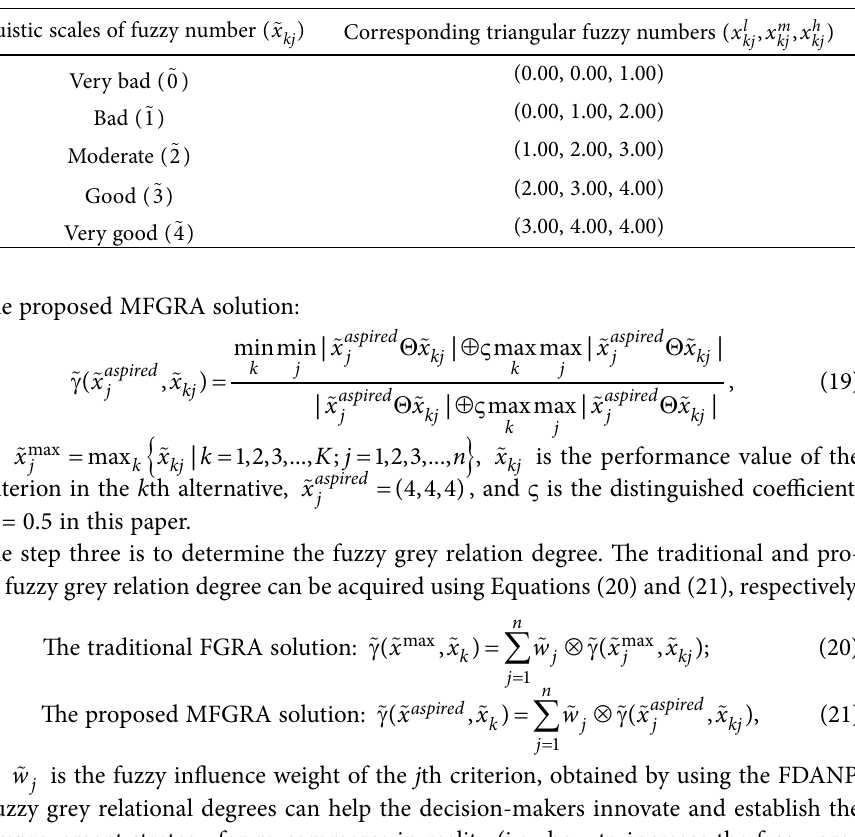
Table 2. Membership functions for MFGRA questionnaire